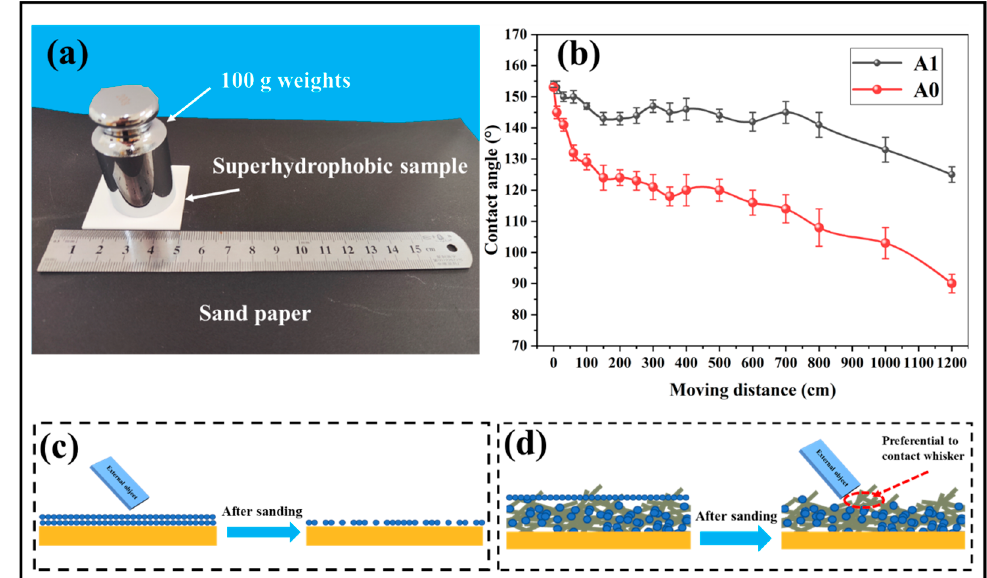
Figure 7. ( a ) Digital photos of the superhydrophobic surface stability testing process; ( b ) the effect of different samples moving distance on the sandpaper on the contact angle; ( c ) A0 sample scraped by sandpaper model; ( d ) A1 sample scraped by sandpaper model.